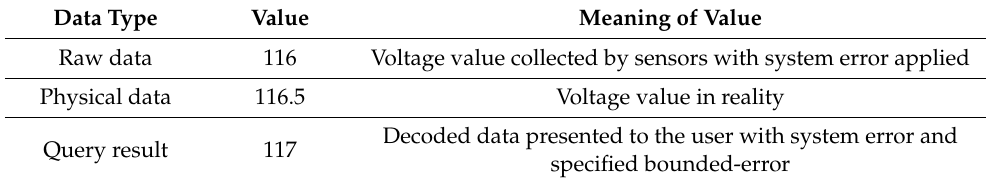
Table 4. An example of data.